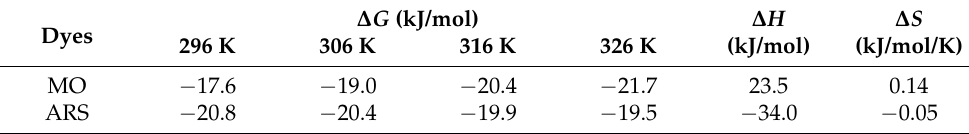
Table 1. Thermodynamic parameters of ARS and MO sorption on clinoptilolite.